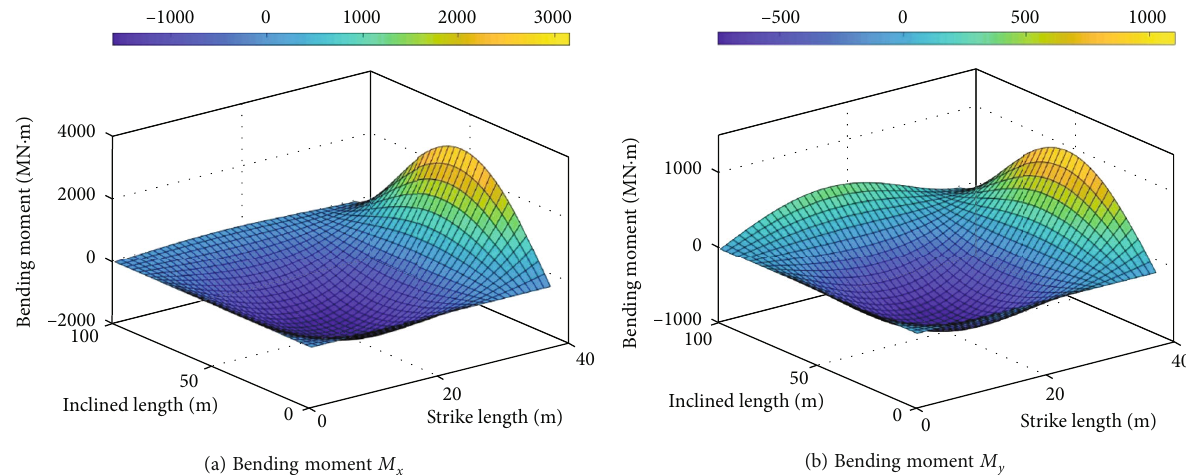
Figure 15: Bending moment of roof model with two sides fi xed and two sides simply supported (simply supported sides are adjacent).